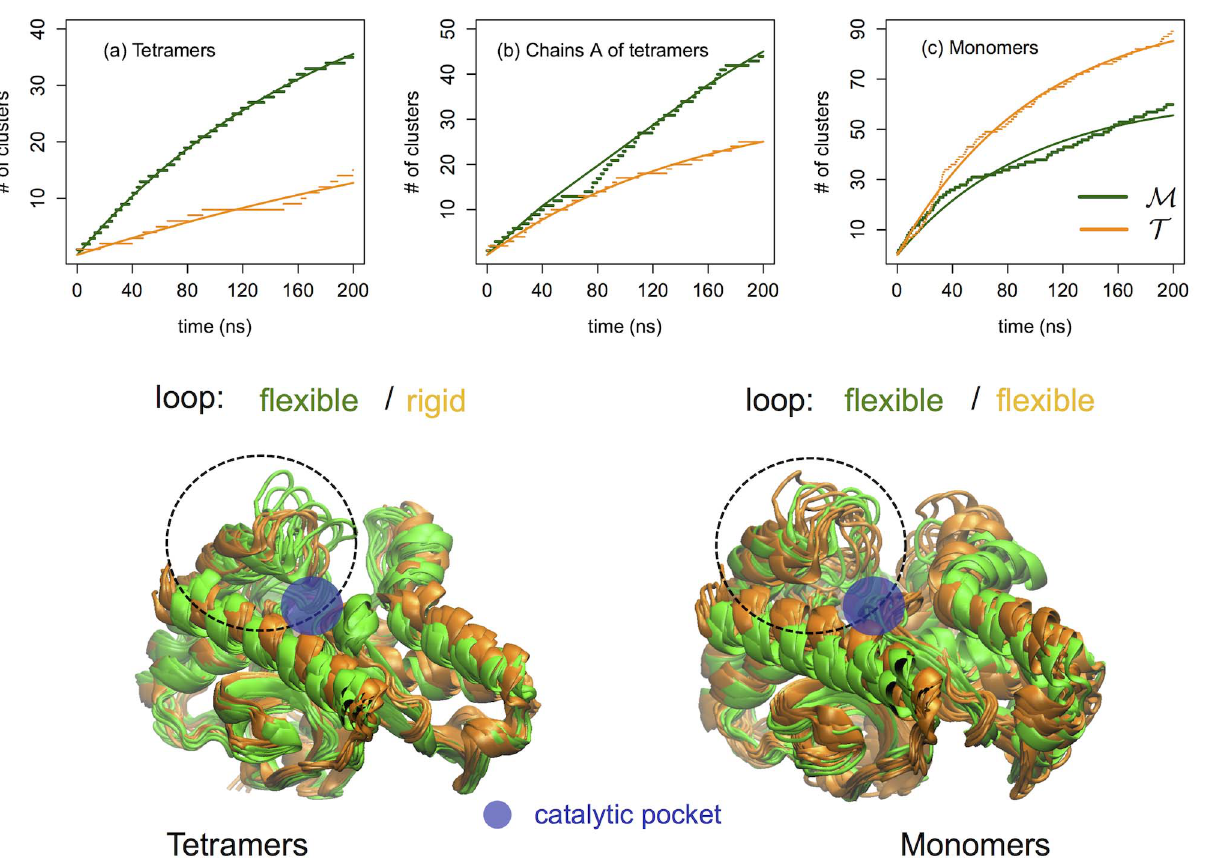
Figure 3. Conformational substates. Upper panel: Dotted lines correspond to the number of clusters at ambient temperature versus the simulation time for the (a) two M and T tetramers, (b) chains A of the M and T tetramers and (c) M and T isolated monomers. Straight lines correspond to an exponential evolution fit of the form N ~ N ? ( 1 { e { t = t ) . Lower panel: Thermophilic protein is in orange and mesophilic in green color. (Left) Cluster leaders for chain A of the tetramers’ clustering and (right) cluster leaders of the monomers’ clustering. Notice the anchoring of the loop at the active site of tetrameric T on the left with respect to the flexible loop of its isolated monomer on the